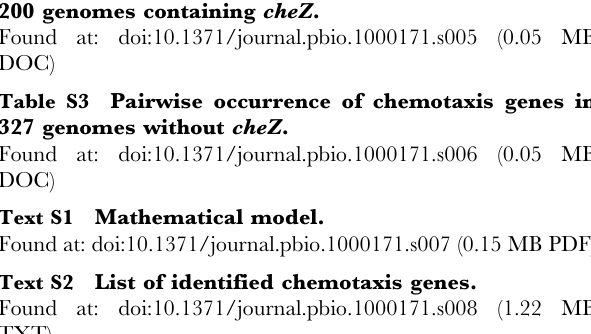
Table S2 Pairwise occurrence of chemotaxis genes in 200 genomes containing cheZ .